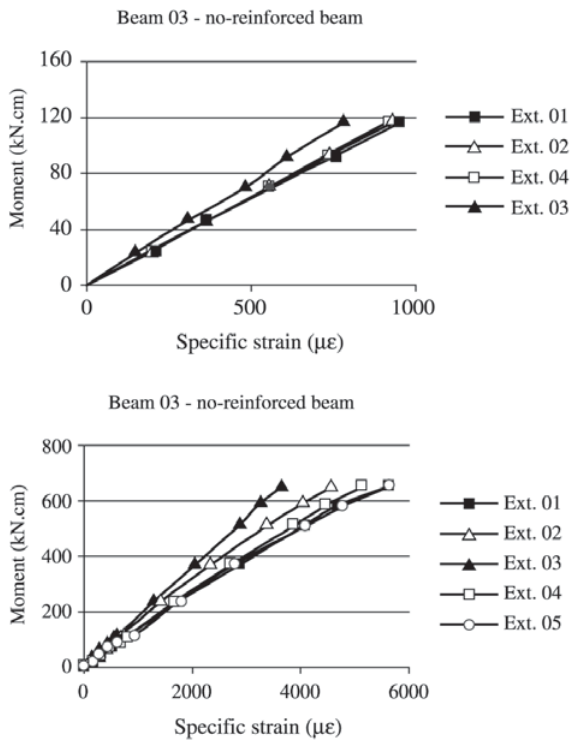
Figure 5. Moment x specific strain - Pinus beam 03 with section (6 × 12 cm).